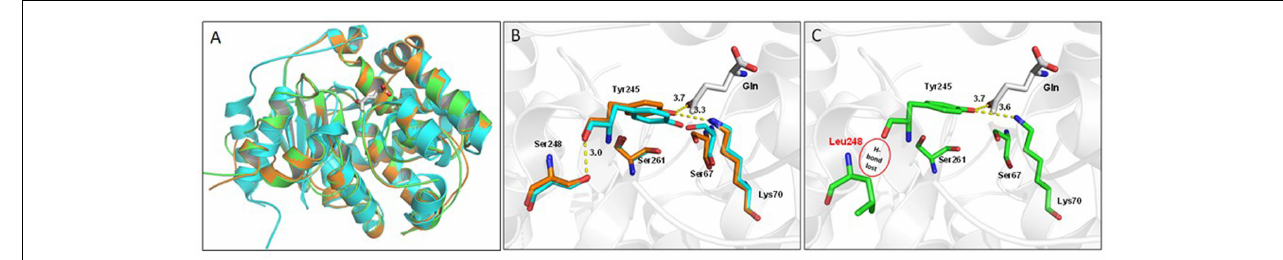
FIGURE 8 | Structural comparison of glutaminase from Escherichia coli (YbaS, 1U60, cyan cartoon), B. microti CCM4915 (orange), and B. abortus ATCC 23448 (544) (green). (A) Superimposition of the three glutaminases, the substrate Gln is depicted as white thick sticks and enzyme secondary elements are shown in cartoon representation. (B) Close-up view of the active site of YbaS from E. coli and GlsA from B. microti showing key residues involved in the substrate-binding site. Residue numbering refers to B. microti , with Ser67, Lys70, Tyr245, Ser248, and Ser261 corresponding to the E. coli counterparts Ser66, Lys69, Tyr244, Ser247, and Ser260, respectively (Brown et al., 2008). The network of hydrogen bonds including that between Ser248 and Tyr245 a residue connected to Gln is shown (all distances are labeled in Å). (C) Same as in B for B. abortus with Ser248Leu mutation indicating the absence of a hydrogen bond (highlighted by a red circle) and a destabilization of the rest of the